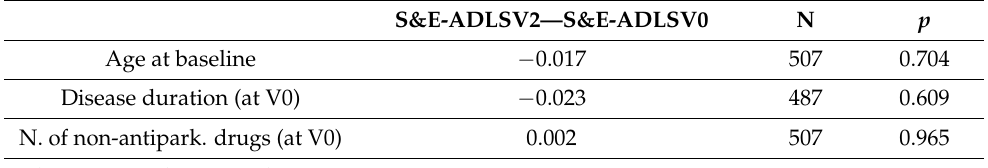
Table 1. Correlations between the change in the S&E-ADLS score and other disease-related variables in PD patients from V0 (baseline) to V2 (2 years ± 1 month).